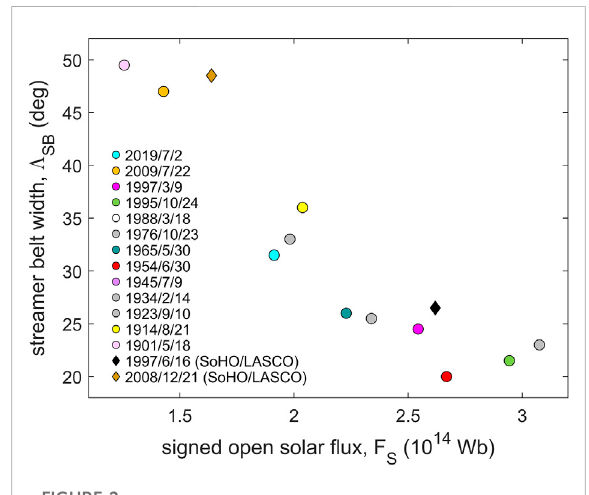
FIGURE 2 The variation of inferred streamer belt width Λ SB for observations within 1 yr of sunspot minimum, with the annual mean of the Open Solar Flux (OSF) derived from geomagnetic activity. The circles are for total solar eclipse estimates and the diamonds are two values derived from SoHO/LASCO coronagraph observations (Lamy et al.,